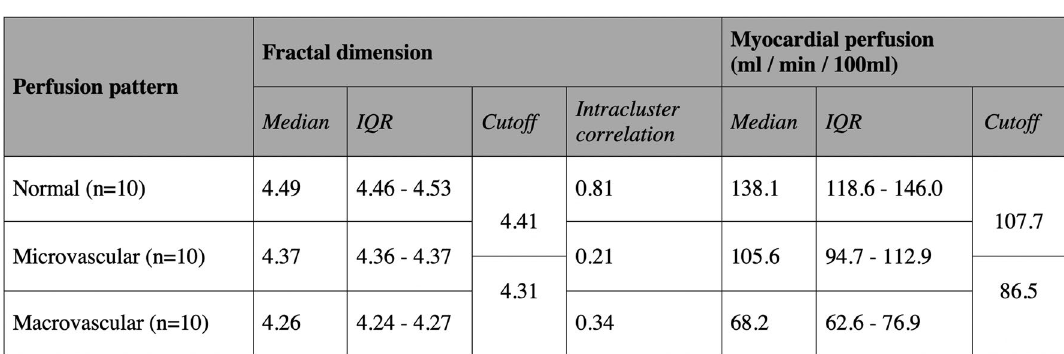
Table 3. Results of fractal analysis for detecting and classifying ischemia. The fractal dimension (FD) is the quantitative parameter for complexity of perfusion and is given after elimination of intra-patient clustering. IQR—interquartile